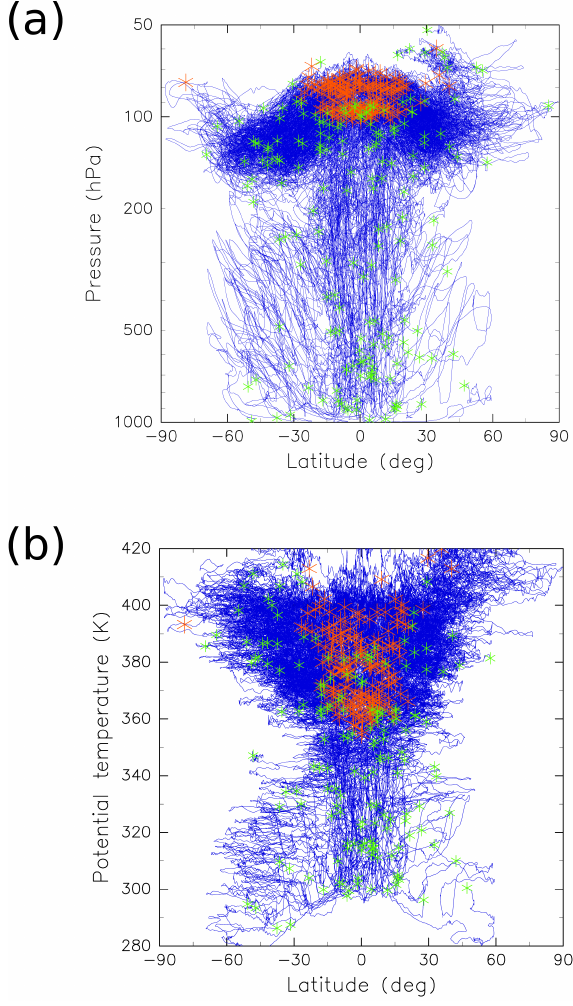
Figure 1. The meridional projections in (a) pressure and (b) isen- tropic coordinates of 90-day kinematic backward trajectories ini- tialized at 400K potential temperature surface at 15 January 1999. Initial positions are set at 5.0 ◦ longitude by 1.5 ◦ latitude grid points covering the tropical zone within 30 ◦ N and S from the Equator. Those shown here are the subsets in which the initial positions are trimmed to 20.0 ◦ by 6.0 ◦ grid points for visual clarity. The red as- terisks are the Lagrangian cold points, while the green asterisks are the termination points of trajectory calculations. The calculations stop if the backward extension of the trajectories hits the surface of the Earth in less than 90 days before